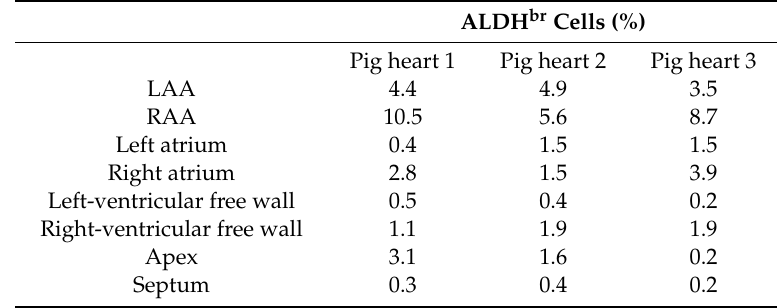
Table 1. Percentages of aldehyde dehydrogenase bright (ALDH br ) cells in di ff erent compartments of the pig heart. ALDH br Cells (%) Pig heart 1 Pig heart 2 Pig heart 3 LAA 4.4